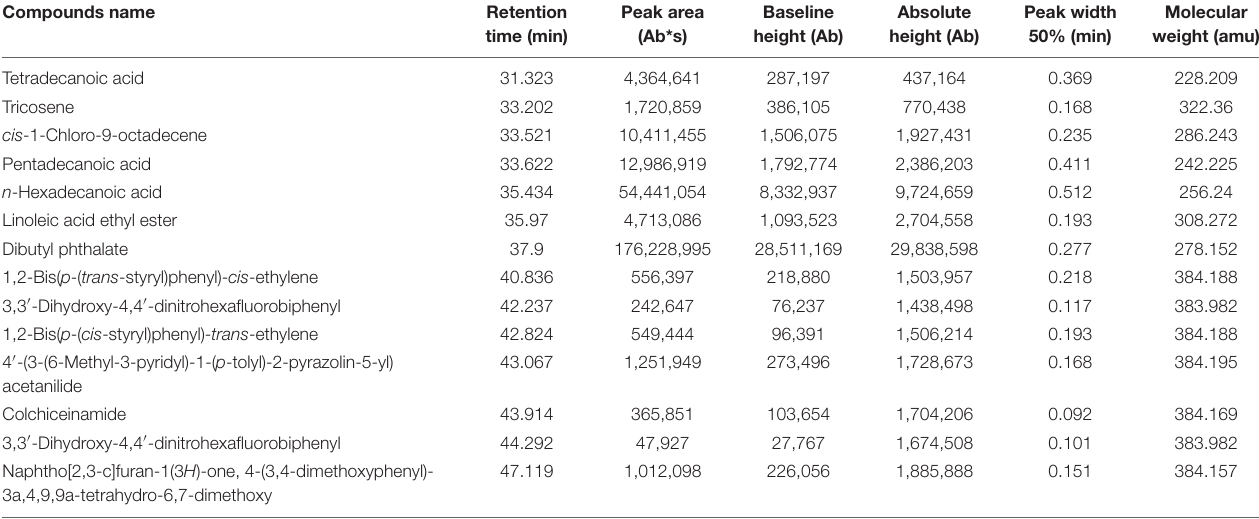
TABLE 2 | Identification of chemical composition of the Streptomyces BITDG-11 extract by GC-MS. Compounds